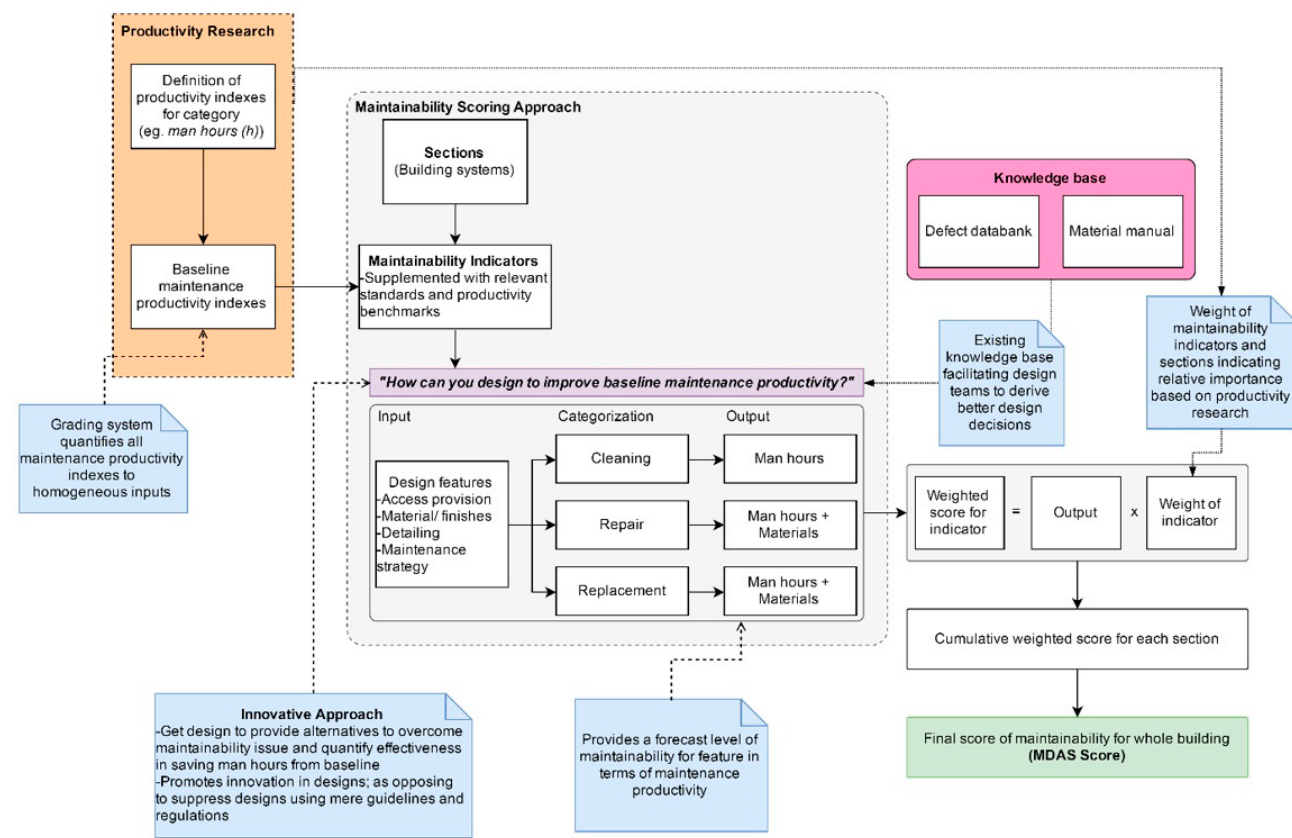
Figure 5. Formulation of the Maintainable Design Appraisal System (MDAS).